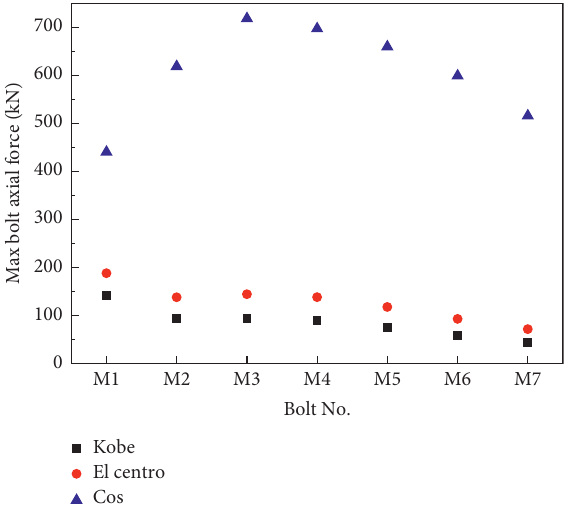
Figure 7: Maximum axial force of bolts under different types of seismic waves.